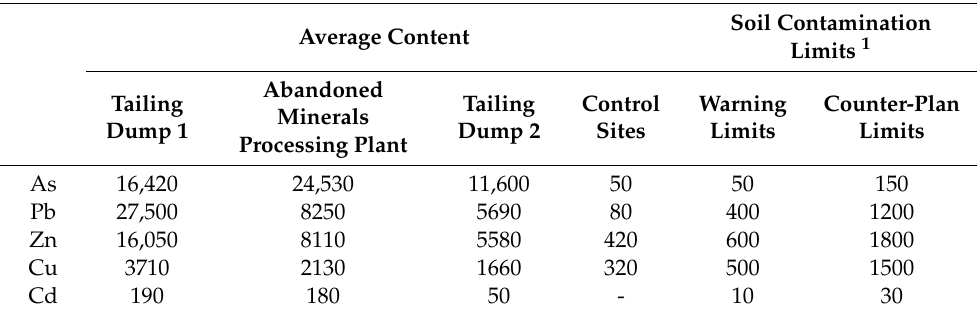
Table 1. Representative average content of As and heavy metal elements in soils for sampling sites and contamination limits prescribed in the soil environment conservation act in Korea (unit: mg / kg). Soil Contamination Average Content Limits